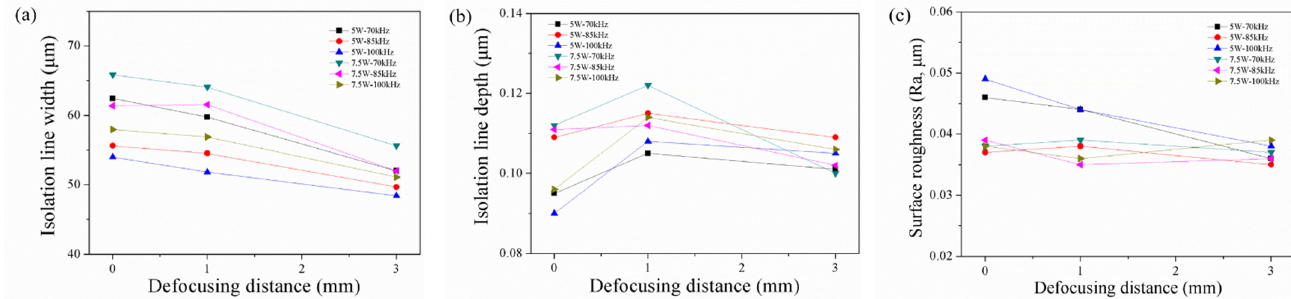
Figure 5. Relationship between the defocusing distance and ( a ) isolation line width, ( b ) isolation line depth, and ( c ) surface roughness of PC within the isolation line.